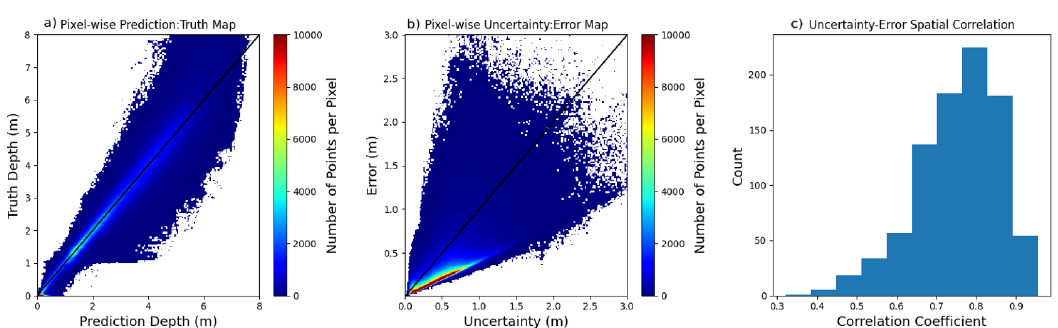
Figure 11. Examples showing correlations between the error and uncertainty. ( a ) A 1:1 plot of the pixel-wise predicted depth and the true depth, allowing easy visualization of the spread from the line. ( b ) The error at each pixel as a function of its uncertainty value. ( c ) The correlation coefficient from the 2d spatial uncertainty and errors maps that accompany each prediction during